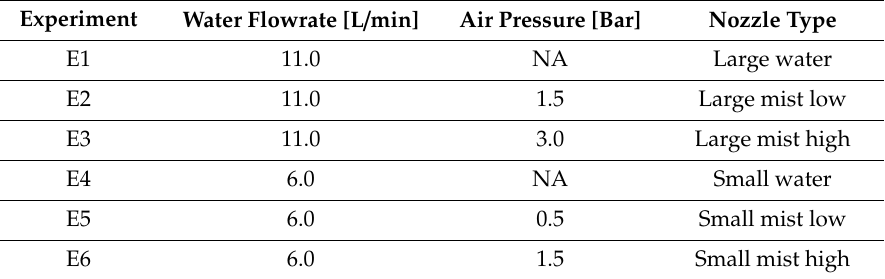
Table 1. List of